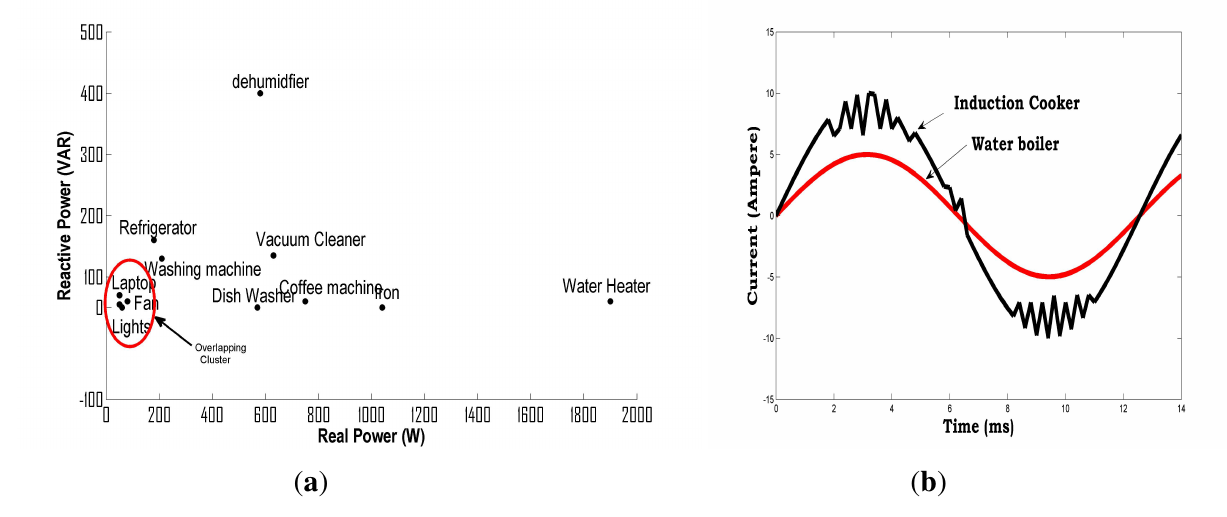
Figure 3. ( a ) Load distribution in P - Q Plane, (From [31]); ( b ) Current draw of linear vs non-linear loads, (From